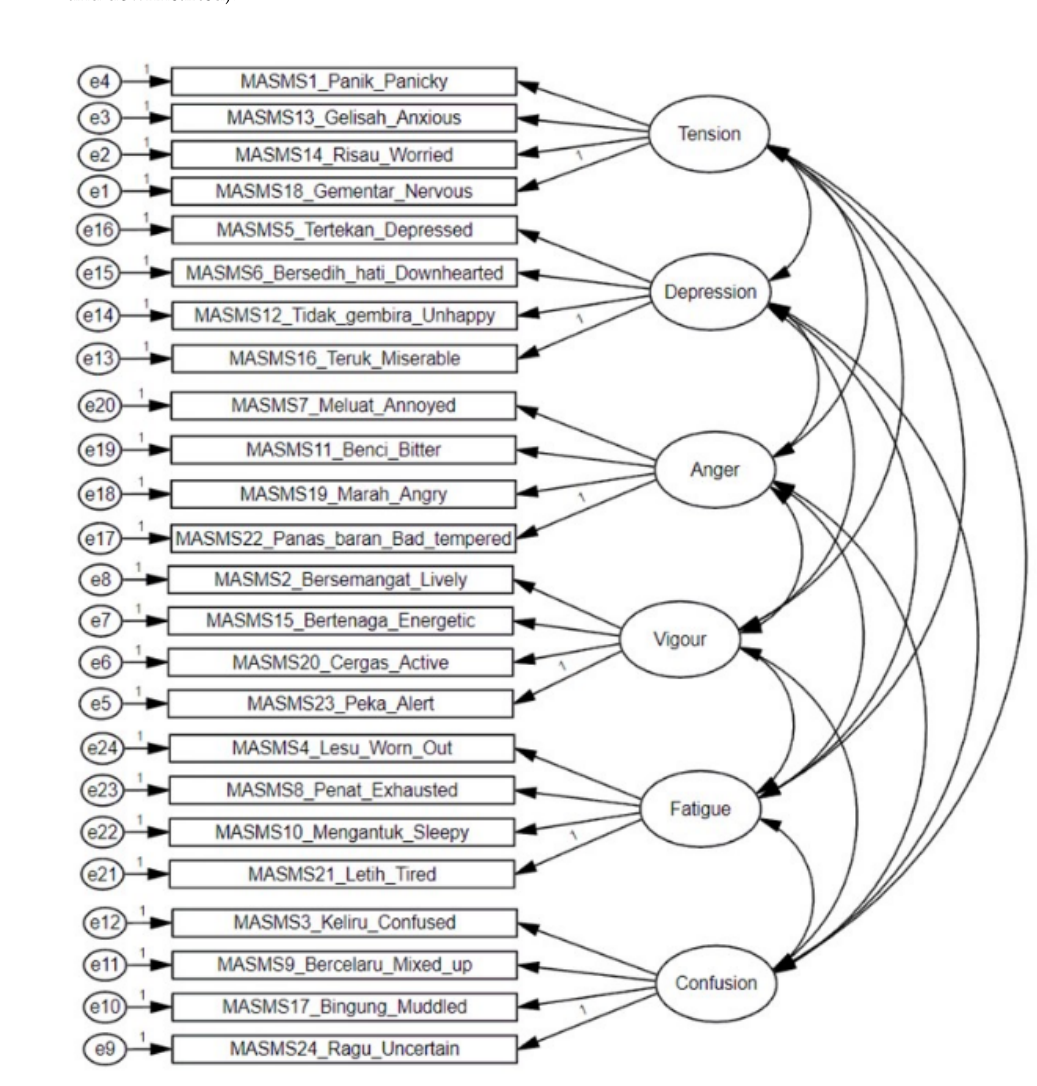
Figure 1. Six-factor model of the Malaysian Mood Scale.